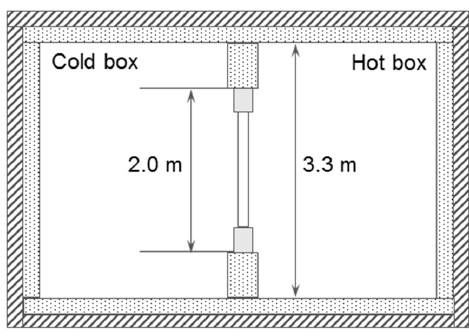
Figure 3. Schematic of the experimental configuration.